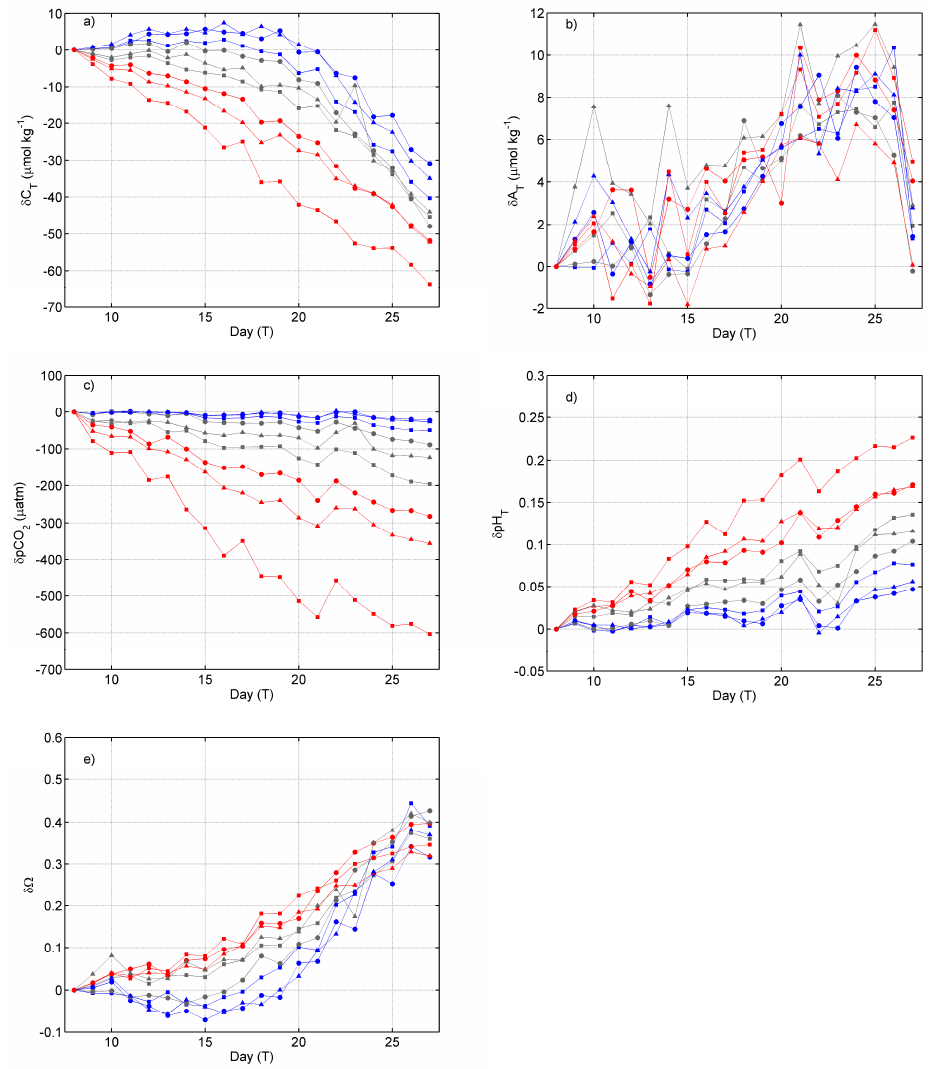
Figure 4 Fig. 4. Cumulative changes relative to the start of the post CO 2 perturbation ( t 8 ) . (a) total inorganic carbon ( C T ) , (b) total alkalinity ( A T ) , (c) partial pressure of carbon dioxide ( p CO 2 ) , (d) pH T on the total hydrogen scale and (e) aragonite saturation state ( (cid:127) ar ) . Red symbols: high p CO 2 mesocosms (M5, M6, M9), grey symbols: medium p CO 2 mesocosms (M1, M4, M8), blue symbols: low p CO 2 mesocosms (M2, M3, M7). The black line represents the natural fjord background